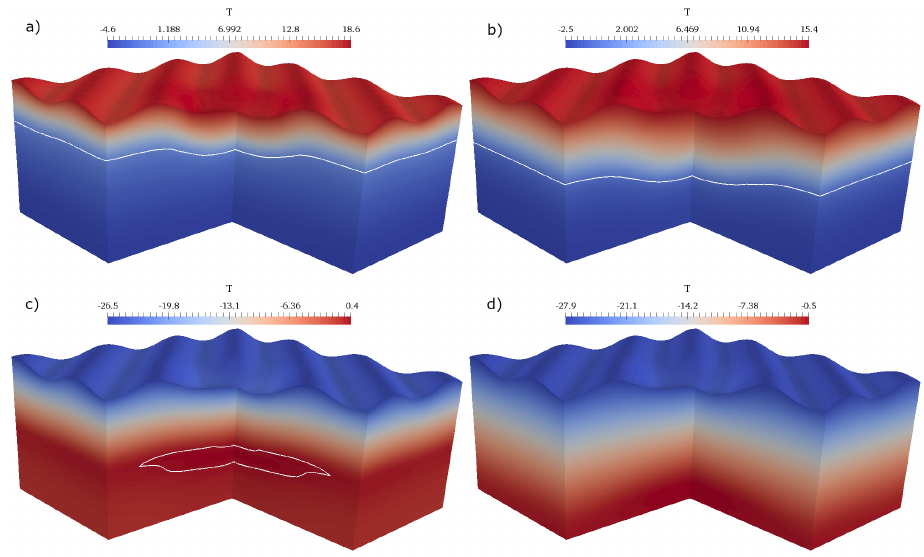
Figure 8. Numerical results for temperature ( a ) τ = 150 ( b ) τ = 200 ( c ) τ = 320 ( d ) τ = 365, where white line is isocline of zero for saturated soils. This results are a coarse grid solution using 8 basis functions ( DOF c =